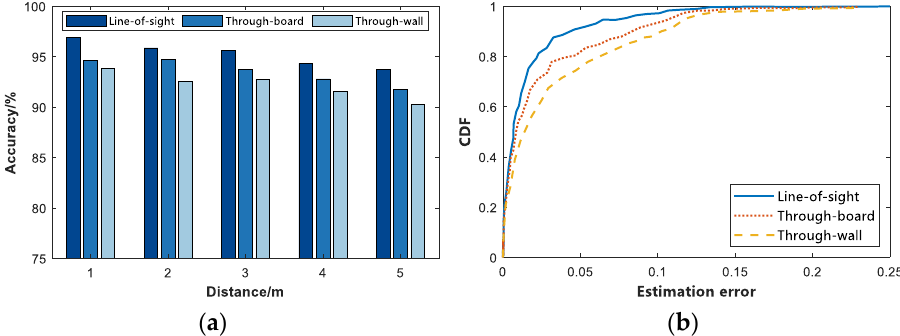
Figure 8. Distribution of accuracy and error accumulation when penetrating different media. ( a ) Accuracy rate. ( b ) Cumulative distribution of errors.